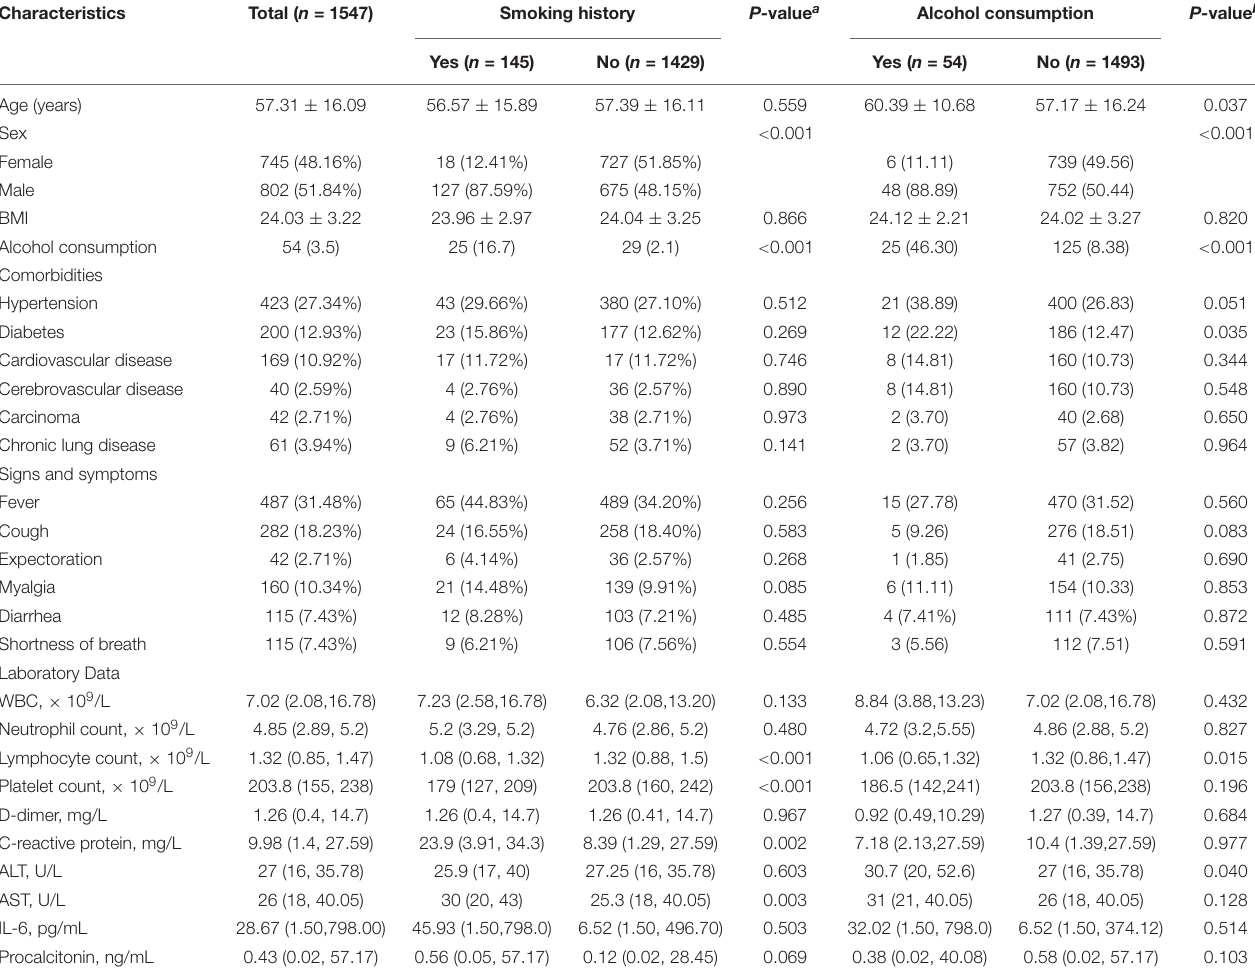
TABLE 1 | Characteristics of patients with COVID-19 with and without smoking history and alcohol consumption.